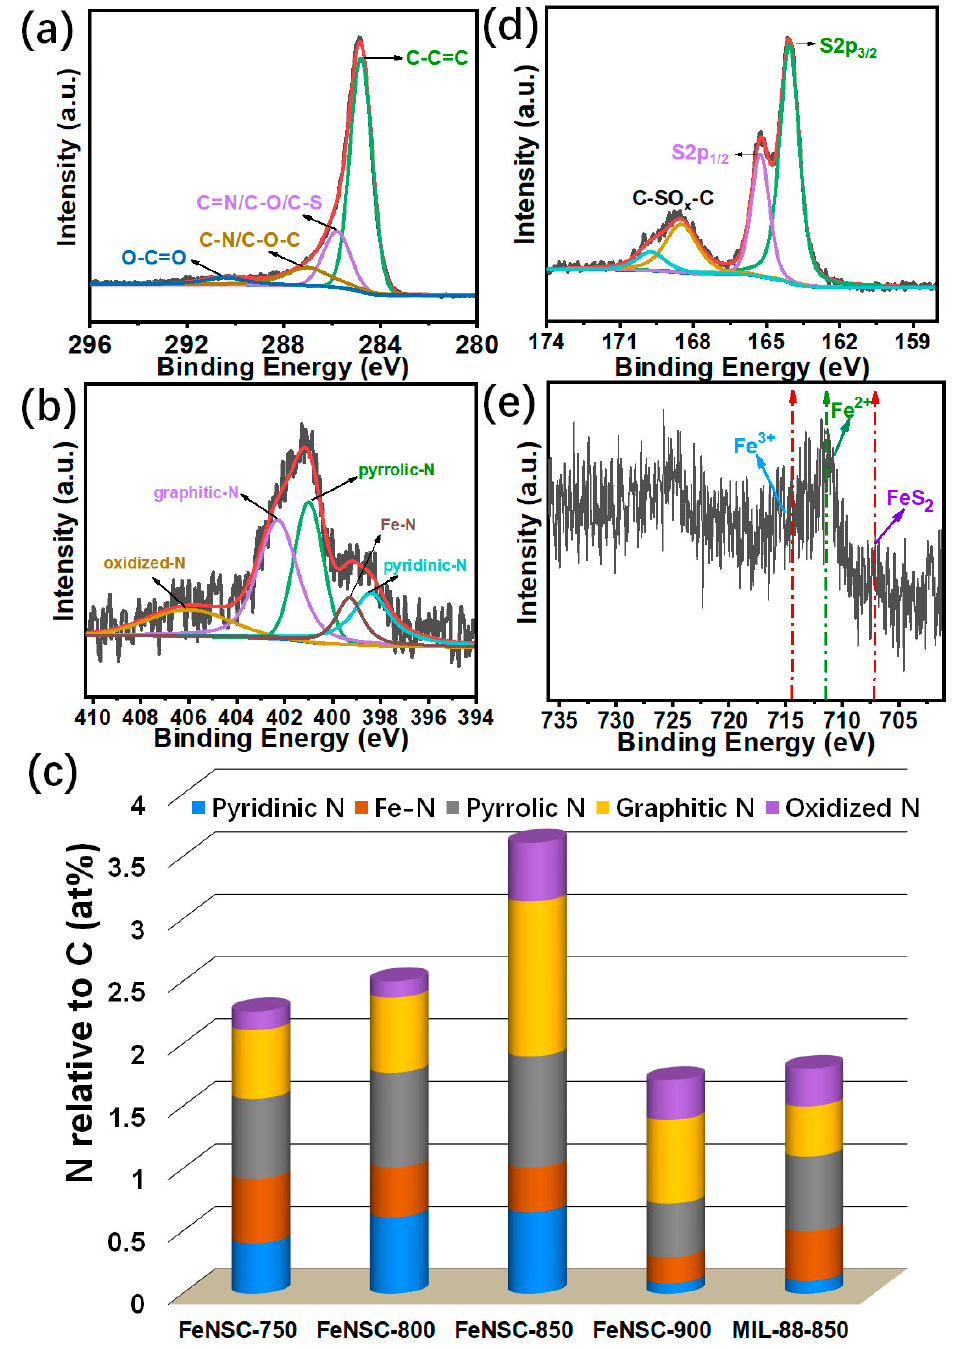
Figure 3. XPS ( a ) C 1s and ( b ) N 1s spectra of FeNSC ‐ 850; and ( c ) the N content relative to C in electrocatalysts of FeNSC ‐ T and MIL ‐ 88 ‐ 850, XPS ( d ) S 2p, and ( e ) Fe 2p spectra of FeNSC ‐ 850.